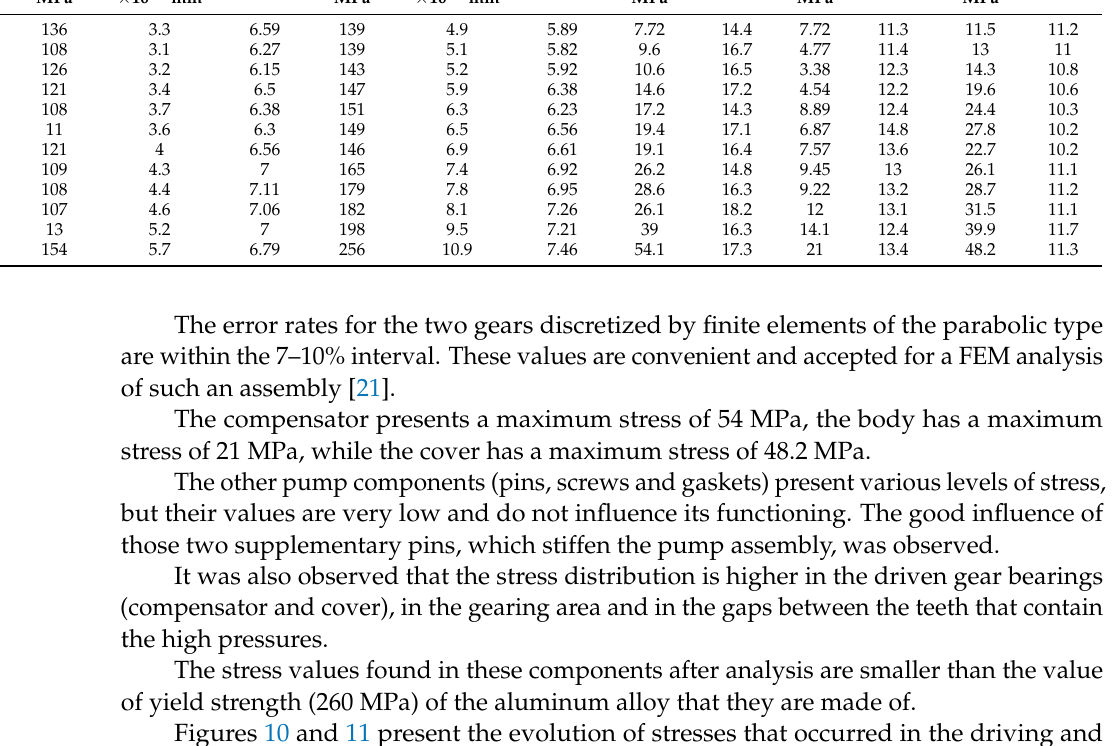
Figure 11. Stress evolution in the body, cover and compensator, depending on applied F d forces . Knowing the simulation practices with FEM and analyzing all these results presented in tables, it can be concluded that the parameterized variants of the pump model meet the conditions for manufacturing [24]. Figure 12 shows the maximum stress location in the main components of the ana- lyzed pump for the third parameterized variant (Table 3). The areas where the stress in- creases, as well the pressure distribution between the gear teeth, are graphically pre- sented, together with the palette of values. In addition, the figure highlights how the meshing of the pump components was prepared. Thus, the finite elements mesh is denser on gears, which leads to lower (and better) error percentages. If the error is relatively high in a particular area of interest, the analysis results will not be considered, and the 3D model must be refined and the calculation repeated. The purpose of refining the pump’s mesh [11] is to achieve a rate of error as small as possible and, therefore, the least possible difference in pump assembly behavior under both virtual and real conditions. To complete this study, many computation iterations were performed, which were required to obtain the imposed objectives regarding a low error percentage.